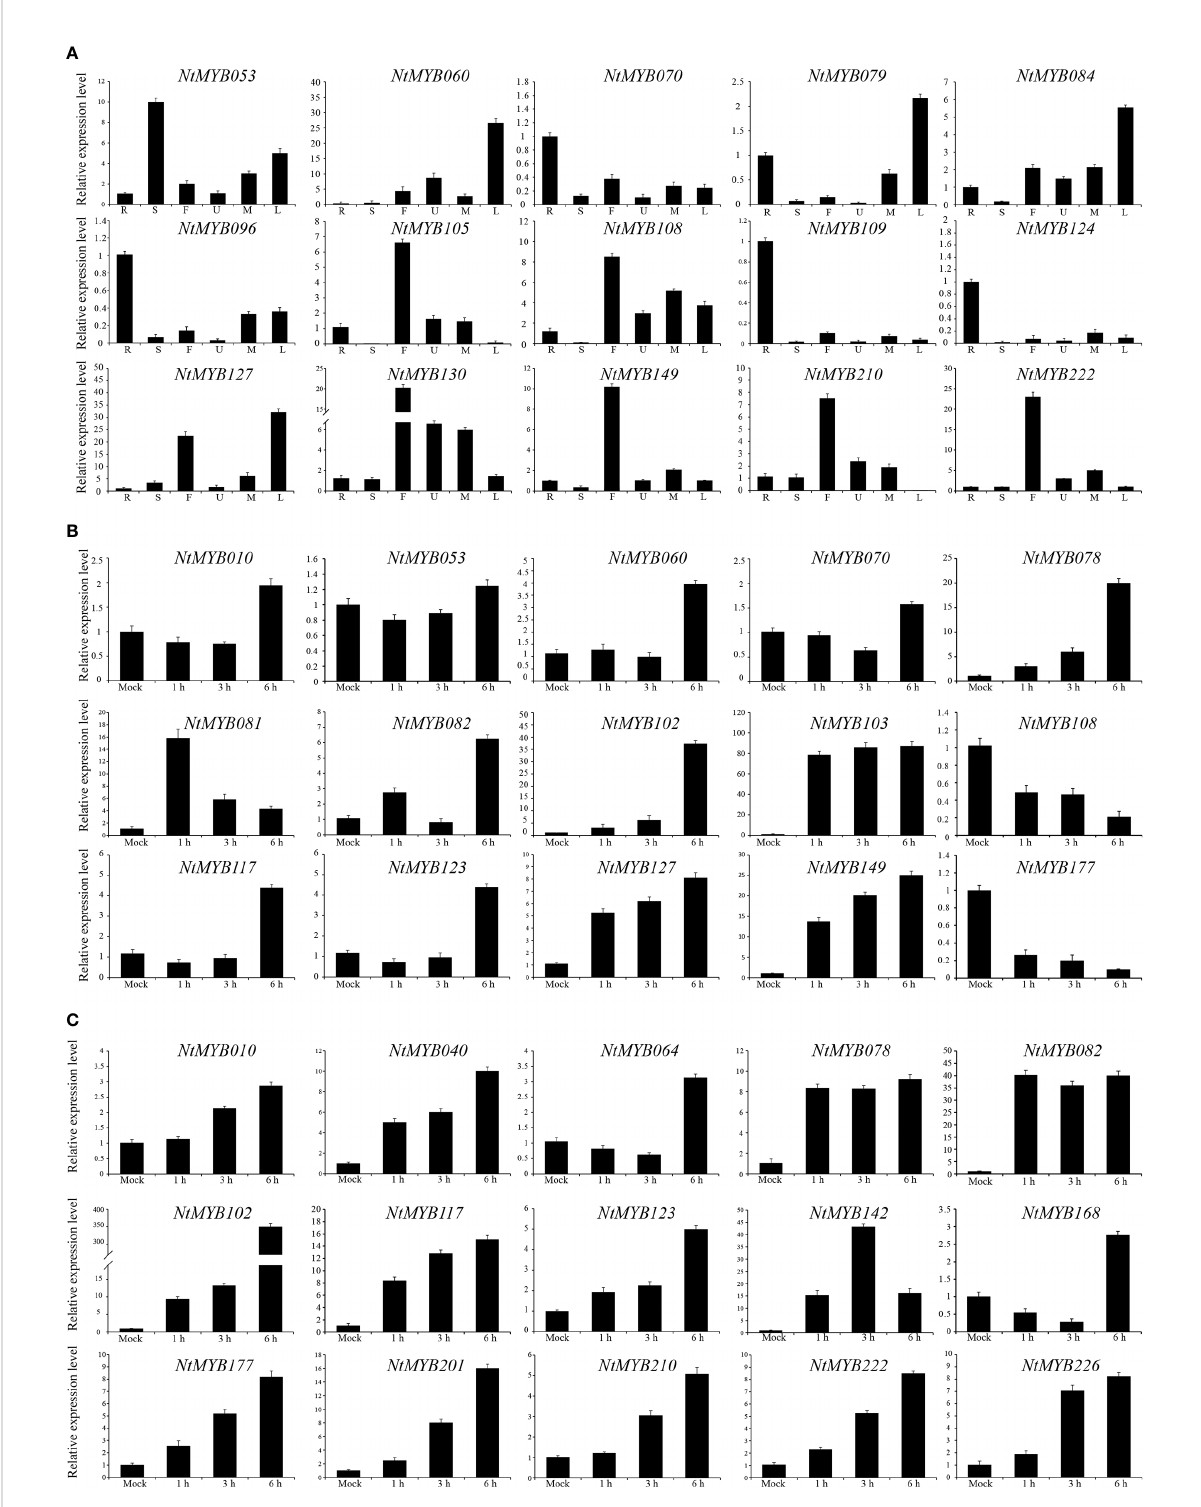
FIGURE 6 The qRT-PCR analysis of representative NtMYB genes. (A) To verify the tissue speci fi city expression of the representative NtMYB genes, the expression level of each NtMYB gene was calculated relative to the root. (B) The expression level of representative NtMYB genes under salt stress treatments. (C) The expression level of representative NtMYB genes under drought stress